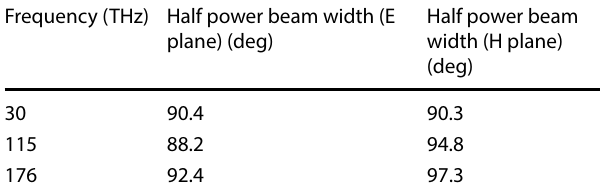
Table 2 Half power beam width of graphene nano patch antenna Frequency (THz) Half power beam width (E plane)